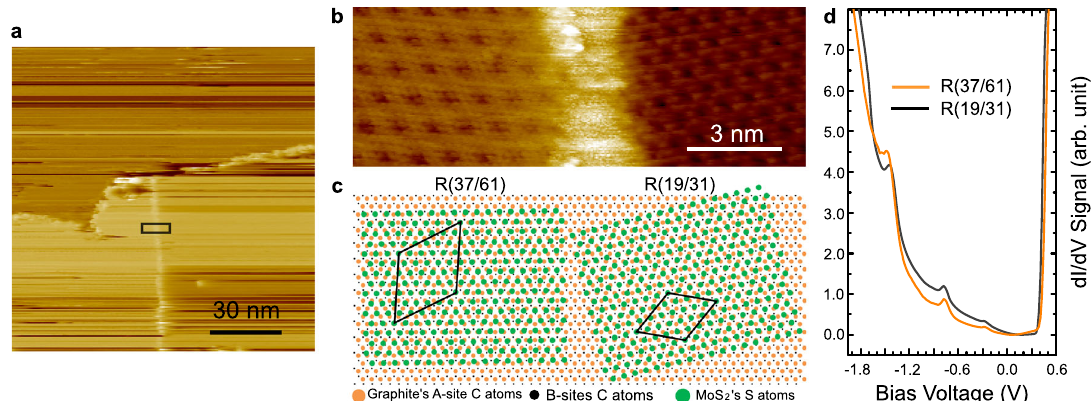
Fig. 1 Two moiré domains. a Large scale STM image ( V bias = − 0.5 V, I set = 0.5 nA) showing the position of the scanning range for b . b An atomically resolved STM image including two distinct moiré patterns on either side of a boundary ( V bias = − 0.5 V, I set = 0.5 nA). c Schematic representations of the two domains with rotational angles of 1° for the left side and 14° for the right side. For clarity, here we only draw the S atoms instead of the complete MoS 2 structure since only the lower S atoms are at the interface, and they occupy the same projected positions as the atomic peaks in the topography image. The superstructures determined for the left and right regions, each indicated by a black rhombus, are R(37/61) and R(19/31), respectively. d The averaged STS for the left and right regions. (Set point: V bias = − 0.5 V, I set = 0.5 nA). The conductivity onset in the conduction band region is located at 0.37 V for R(37/61) and at 0.34 V for R(19/31). In the negative bias range, the peaks appear at − 0.27, − 0.78, and − 1.48 V for R(37/61), and at − 0.29, − 0.78, and − 1.44 V for R(19/31). The tunneling spectra reveal the difference in electronic structure between the R(37/61) and R(19/31)